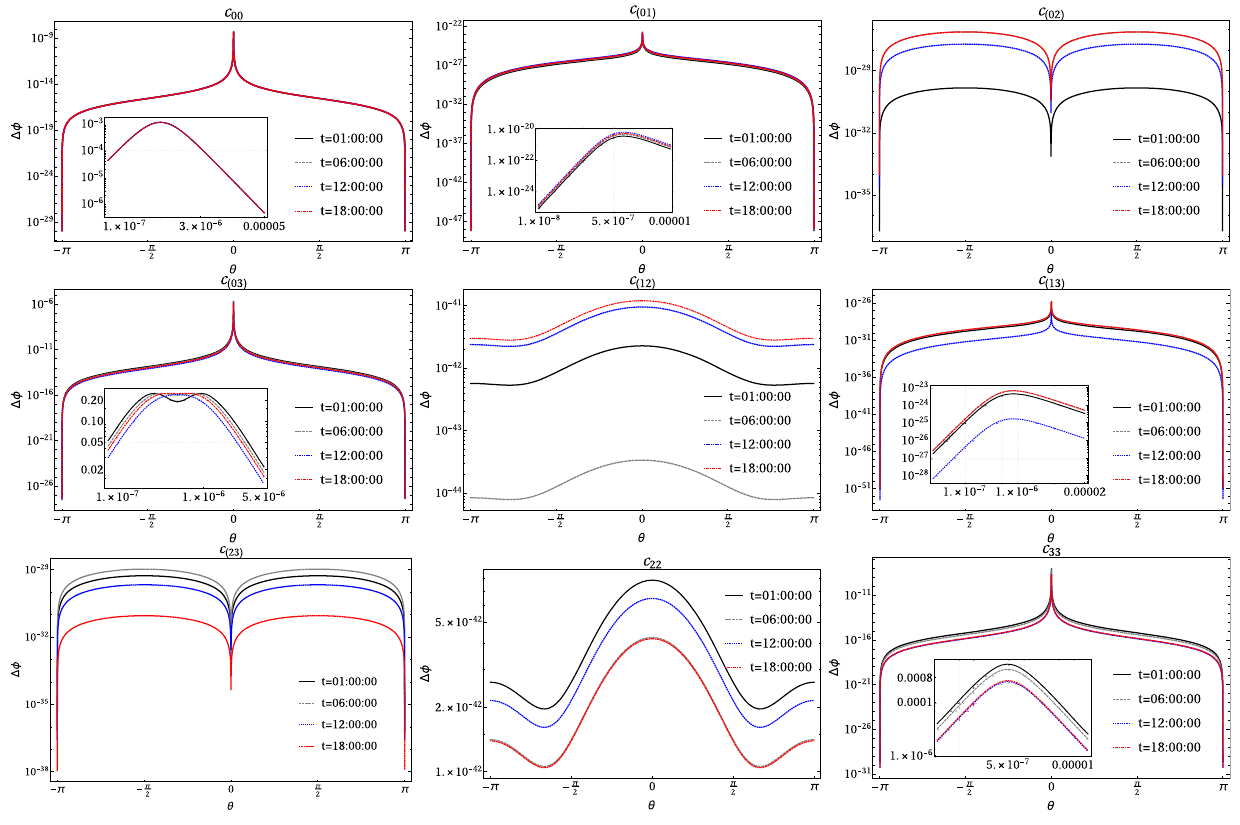
Fig. 2 FC phase, (cid:2)φ | LV e as a function of scattering angle θ for four different times during a day–night. We have taken ϕ = χ = π we assume that only one specific component of c μν con- tributes in the FC phase. Therefore, the FC phase (cid:2)φ | LV different components of c μν in forward scattering of the lin- early polarized laser beam with the energy k 0 ∼ 0 . 1eV and